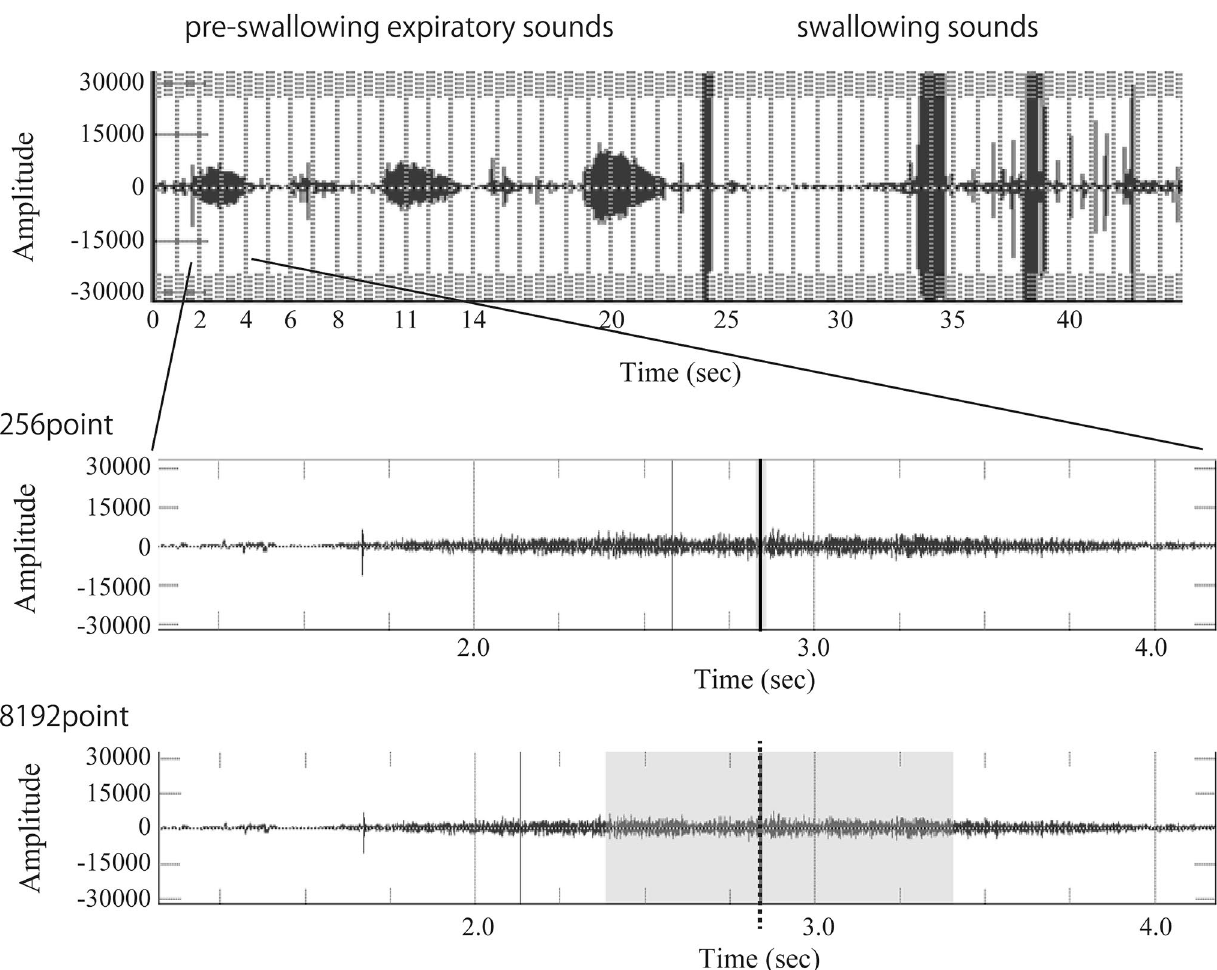
Figure 2. Expiratory sounds and the Hamming window. An example of windowing of 8192 points using the Hamming window of the expiratory sound before swallowing. The three peaks on the left side of the upper figure are the expiratory sounds, and in the lower figure, the leftmost peak is the center of the